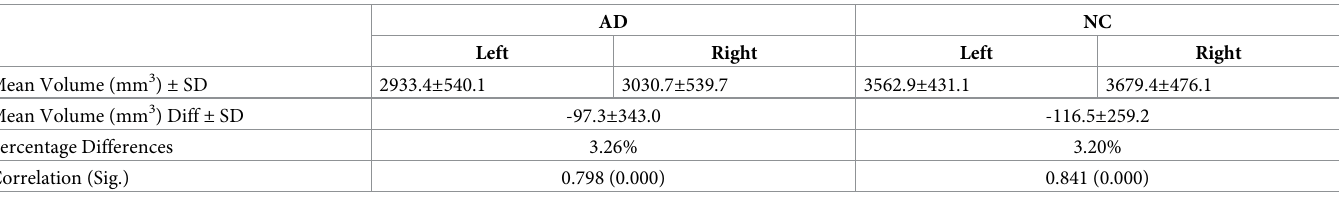
Table 1. Left and right hippocampus volumes of normal controls (NC) and Alzheimer’s diseases (AD). AD NC Left Right Left